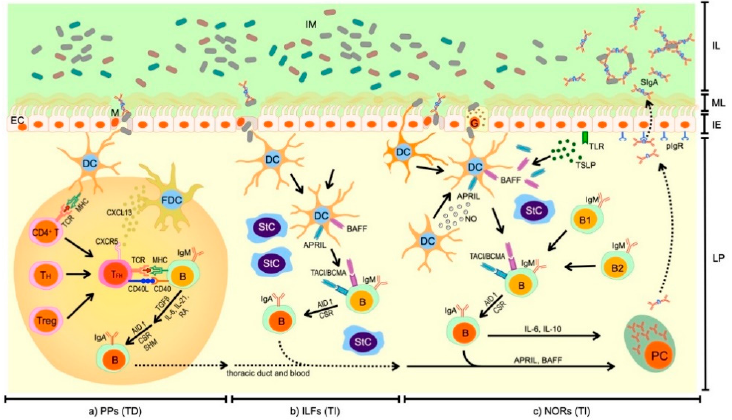
Figure 1. Schematic illustration of T cell-dependent (TD) and -independent (TI) regulation of secretory class A immunoglobulin (SIgA) production in intestinal epithelium (IE) underlying organized structures: ( a ) Peyer’s patches (PPs) and ( b ) isolated lymphoid follicles (ILFs) and ( c ) nonorganized regions